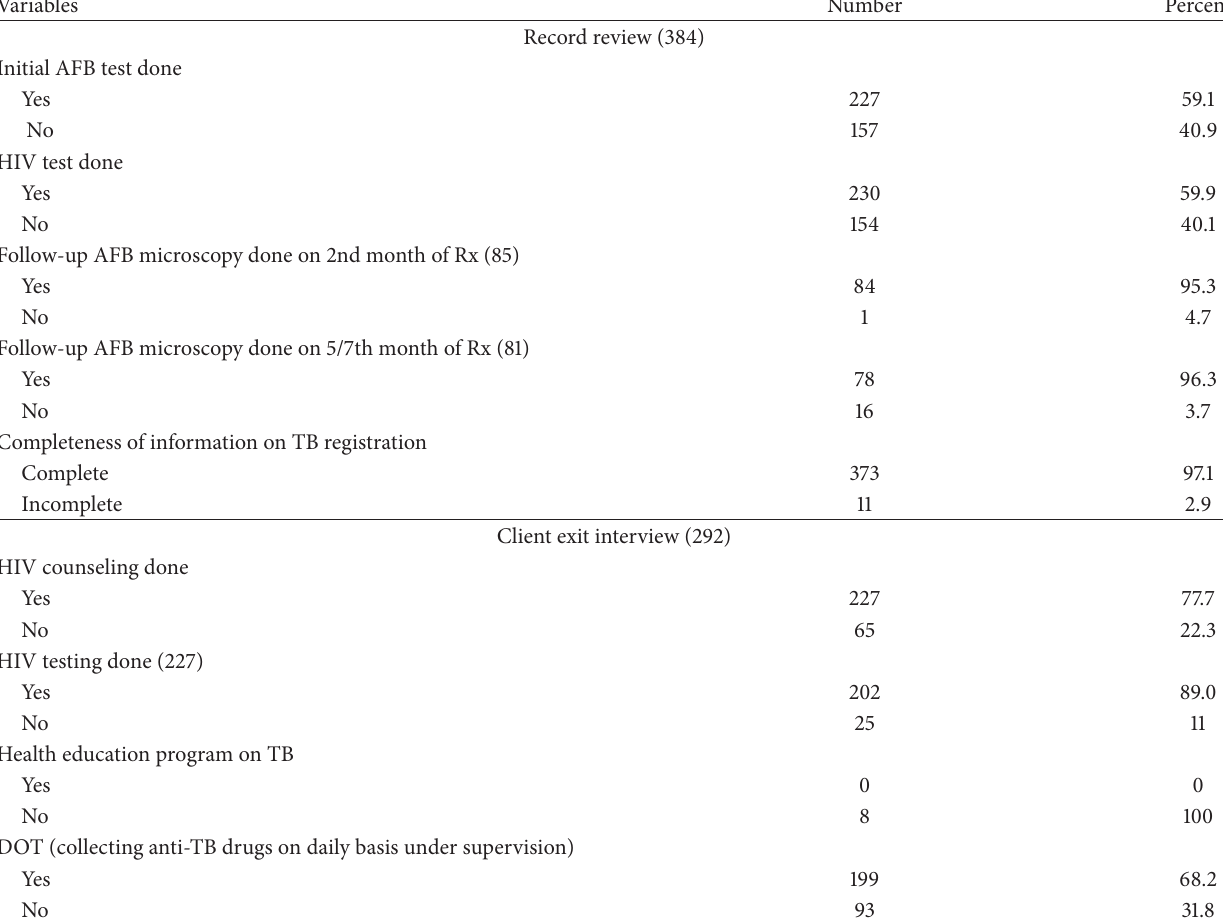
Table 3: Summary of selected process indicators in private health facilities of A. A, 2011.